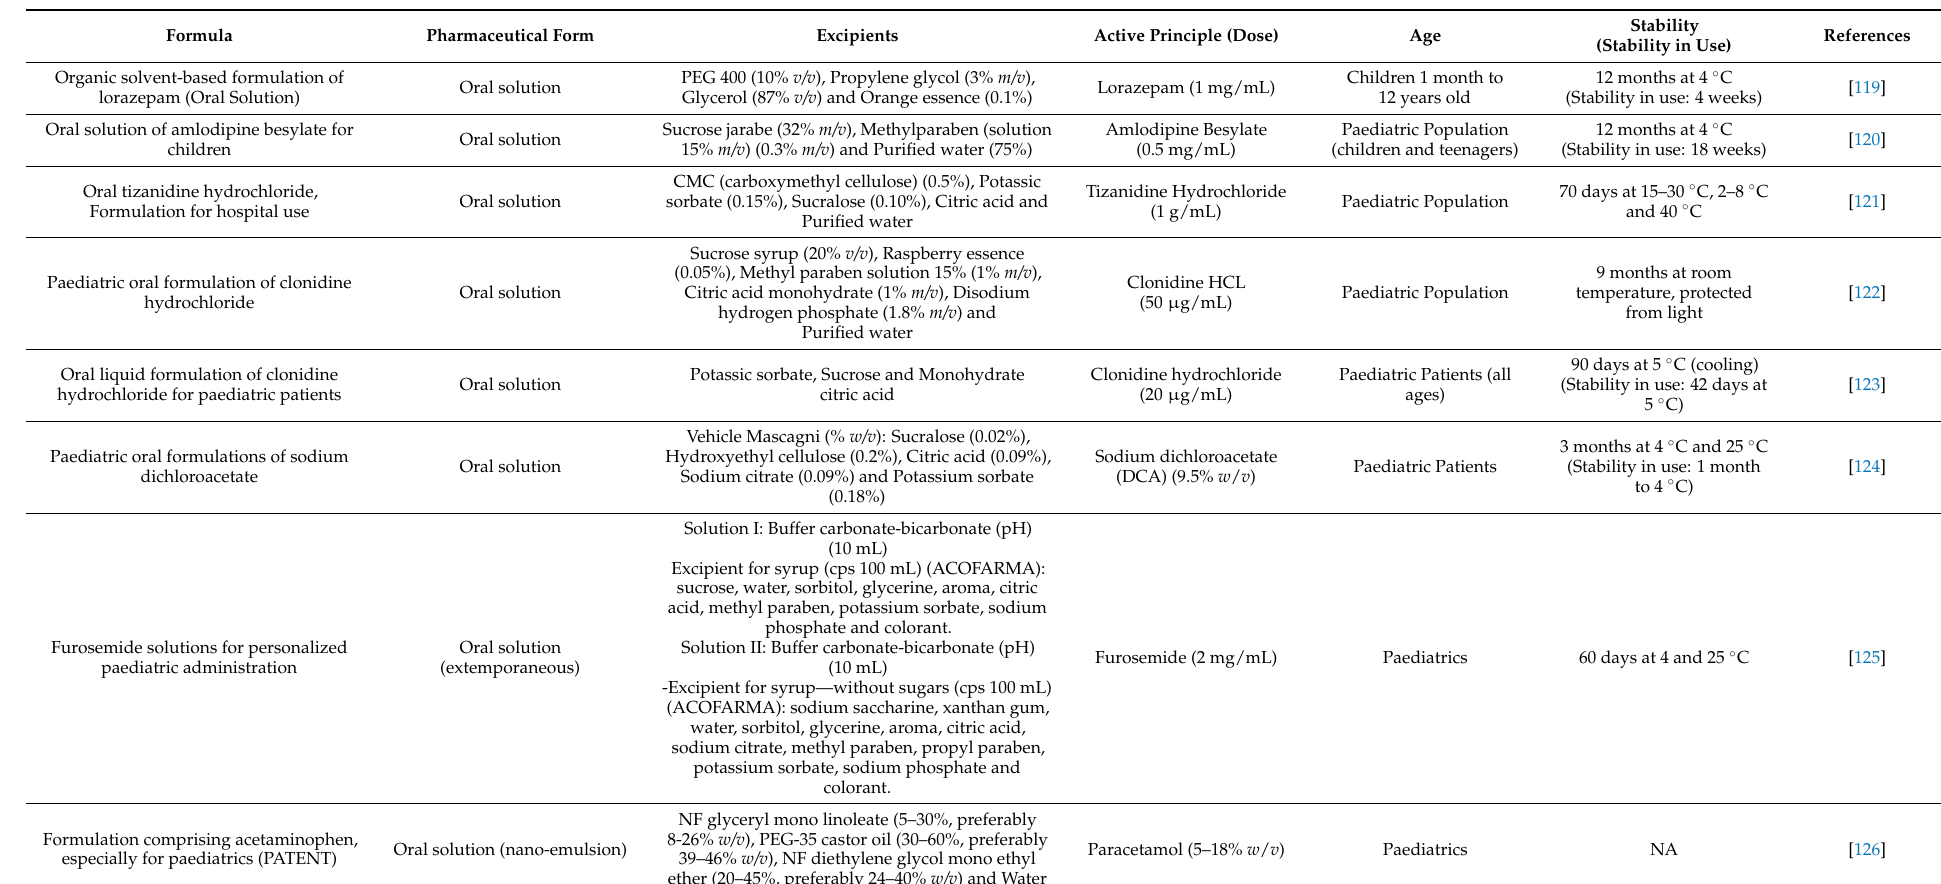
Table A5. Liquid formulations for paediatric use in Research